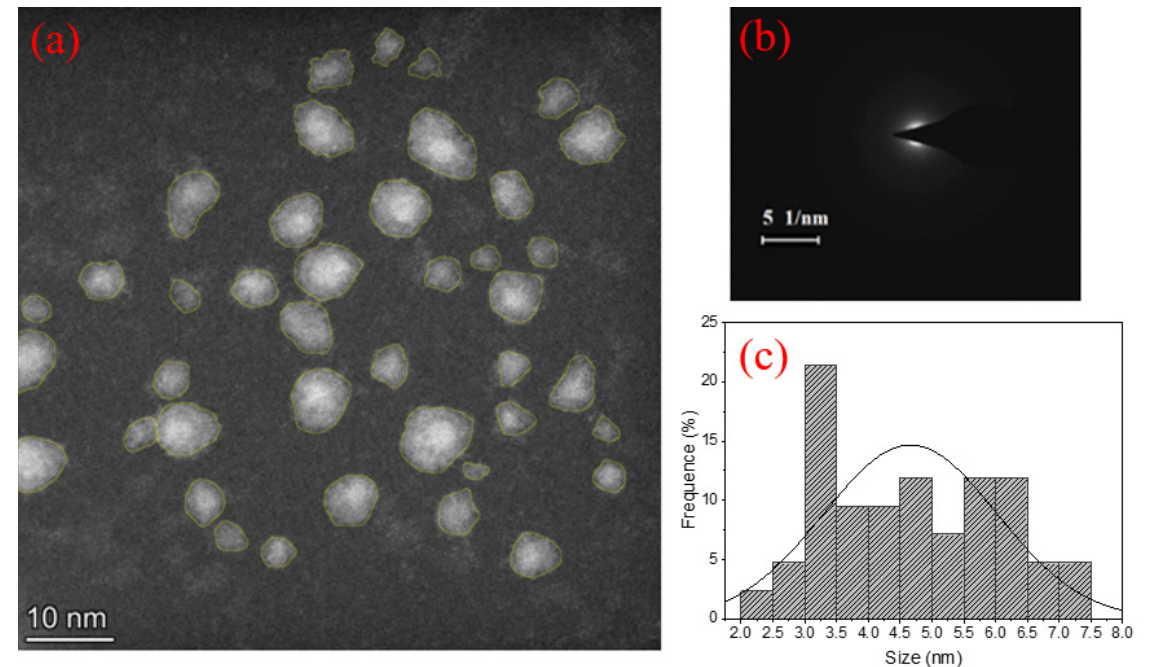
Figure 10. ( a ) TEM image of the GP 4.5Ag sample, ( b ) ED pattern, and ( c ) size distribution.